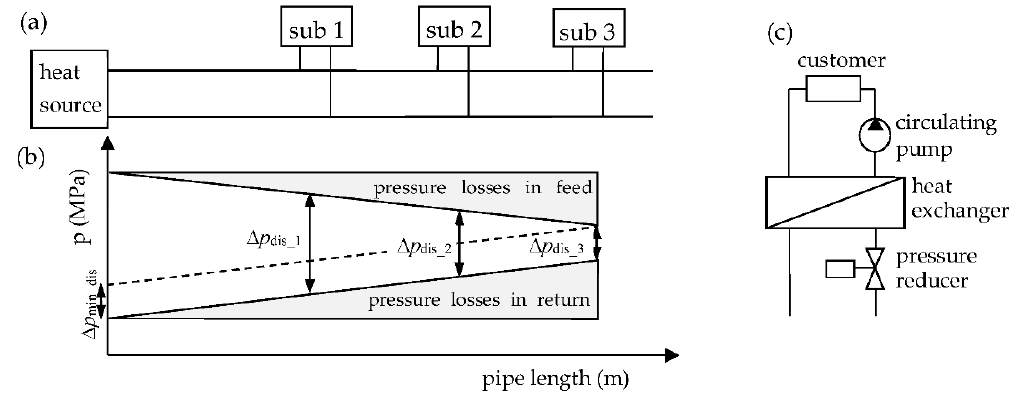
Figure 1. Pressure distribution in DHS: ( a ) two-pipe heating network; ( b ) pressure distribution along the heating pipe; ( c ) substation with heat exchanger.